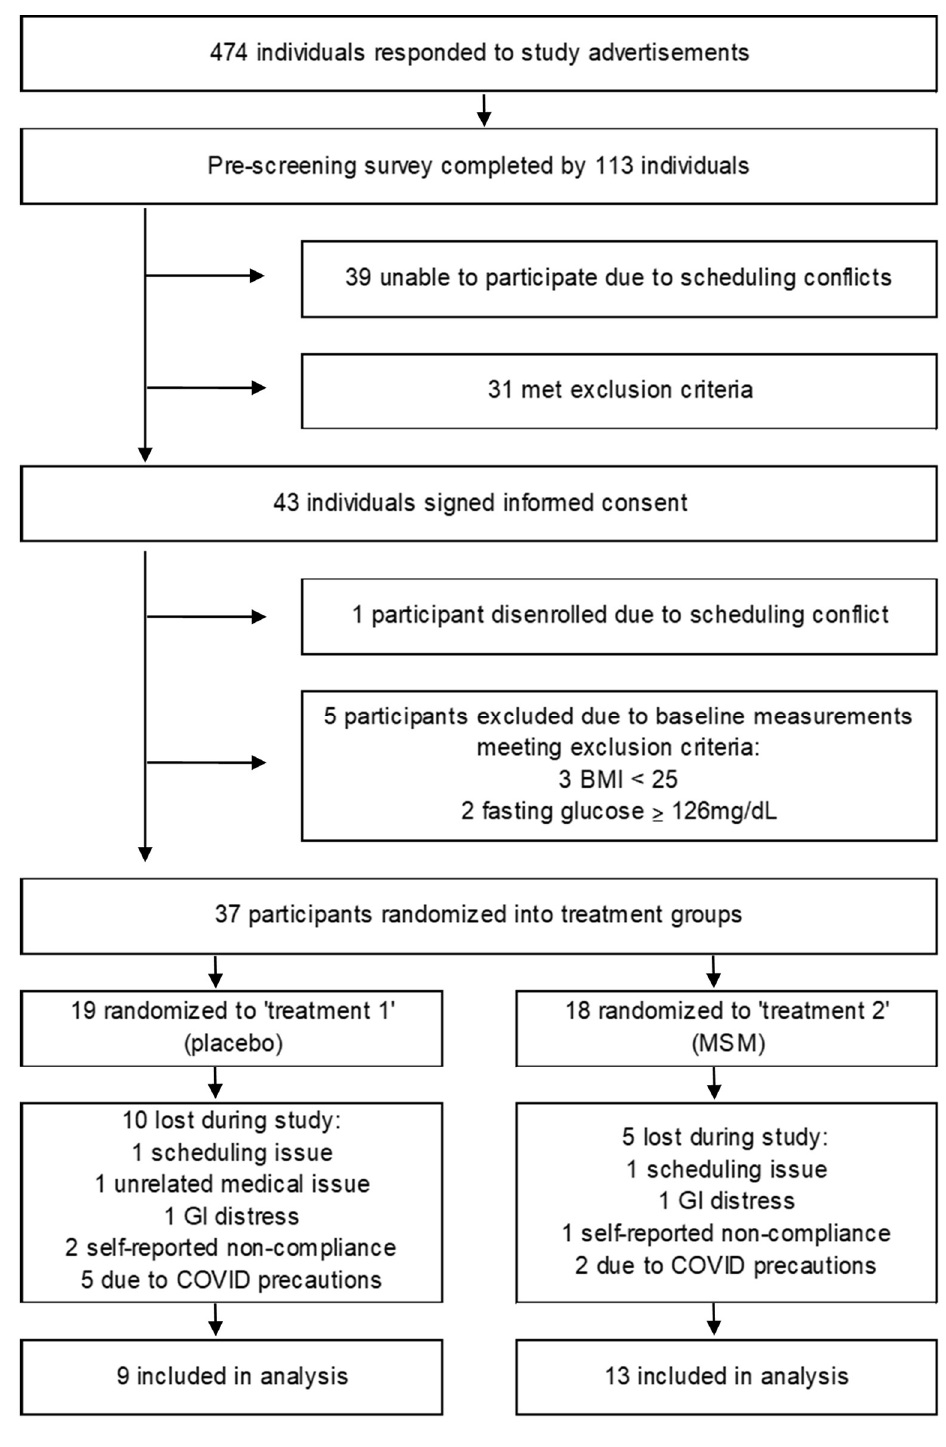
Figure 1. Flow diagram of participant recruitment process. BMI, body mass index; MSM, methylsulfonylmethane.